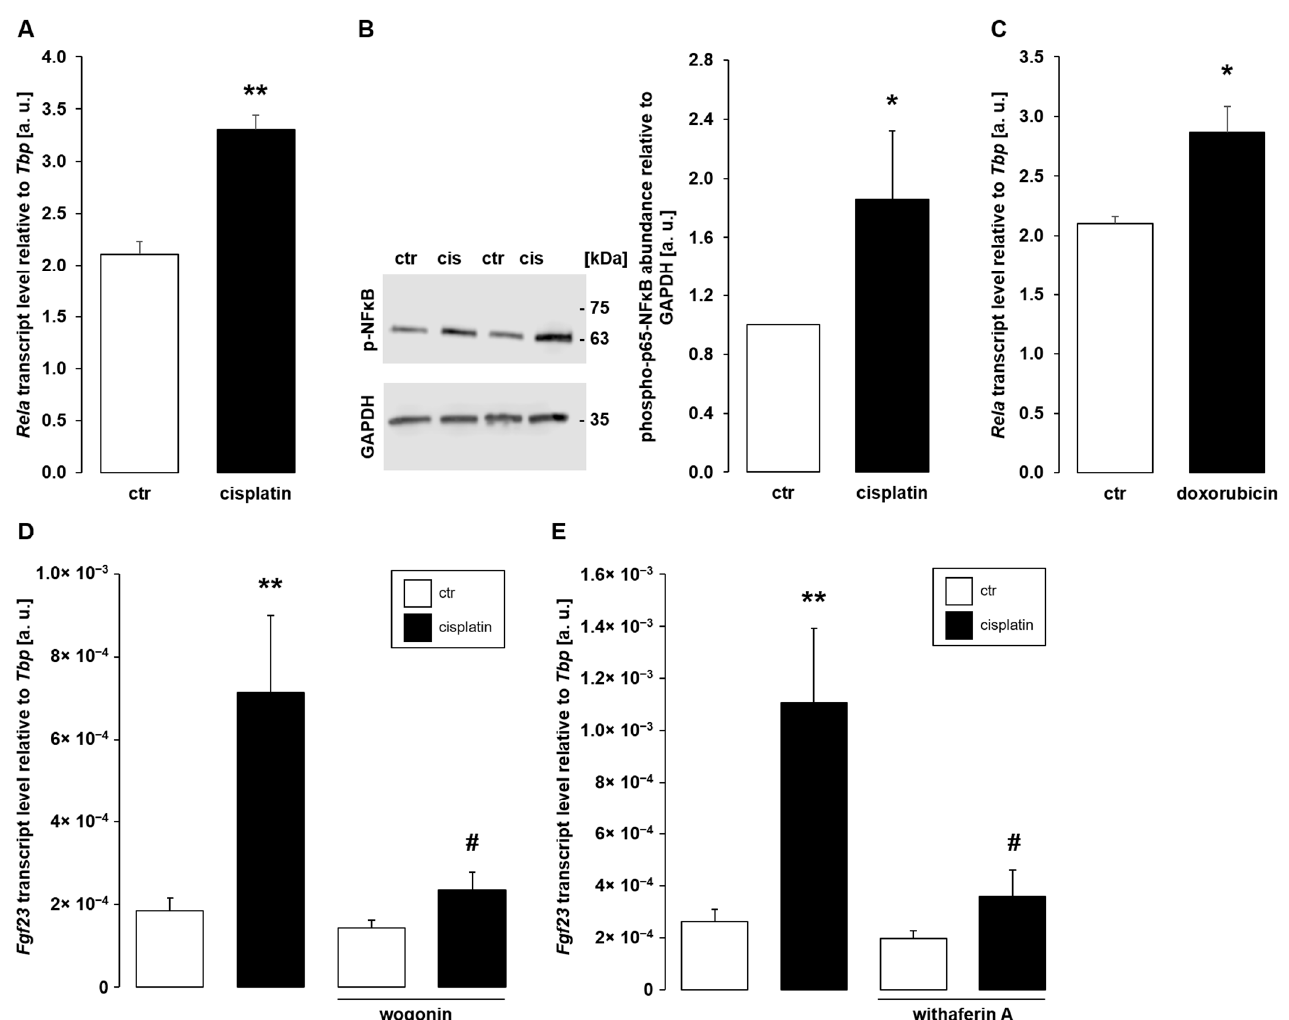
Figure 6. The contribution of NF κ B to the Fgf23 effect of cisplatin. ( A ): Arithmetic means ± SEM of NF κ B subunit p65 ( Rela ) gene expression relative to Tbp in UMR106 cells incubated without (ctr) or with 10 µ M cisplatin for 24 h ( n = 4; student’s t -test). ( B ): Left panel: Original Western Blot demonstrating the abundance of phospho-p65-NF κ B and GAPDH in UMR106 cells treated with (cis) or without (ctr) 10 µ M cisplatin for 24 h. Right panel: Arithmetic means ± SEM of phospho-p65-NF κ B relative to GAPDH abundance ( n = 8; one-sample Wilcoxon signed rank test). ( C ): Arithmetic means ± SEM of Rela expression relative to Tbp in UMR106 cells incubated for 24 h without (ctr) or with 0.3 µ M doxorubicin ( n = 4; student’s t -test). ( D , E ): Arithmetic means ± SEM of Fgf23 dance relative to Tbp in UMR106 cells treated for 24 h with vehicle control (ctr, white bars) or 3 μ M cisplatin (black bars) in the presence or absence of 100 μ M wogonin (( D ); n = 9; Kruskal–Wallis test